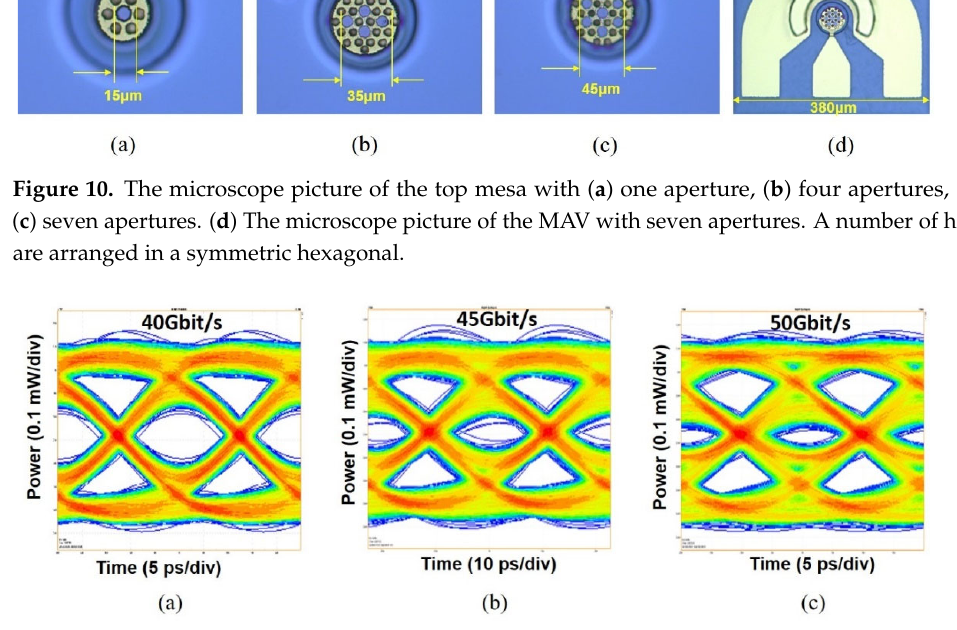
Figure 11. The eye diagram of hexagon-shape MAVs with seven 2.0- µ m apertures across a Figure 11. The eye diagram of hexagon ‐ shape MAVs with seven 2.0 ‐μ m apertures across a 100 m ‐ Figure 11. The eye diagram of hexagon ‐ shape MAVs with seven 2.0 ‐μ m apertures across a 100 m ‐ Figure 11. The eye diagram of hexagon ‐ shape MAVs with seven 2.0 ‐μ m apertures across a 100 m ‐ length MMF, ( a ) 40 Gbit/s, ( b ) 45 Gbit/s, ( c ) 50 Gbit/s. 100 m-length MMF, ( a ) 40 Gbit/s, ( b ) 45 Gbit/s, ( c ) 50 Gbit/s. length MMF, ( a ) 40 Gbit/s, ( b ) 45 Gbit/s, ( c ) 50 Gbit/s. length MMF, ( a ) 40 Gbit/s, ( b ) 45 Gbit/s, ( c ) 50 Gbit/s.